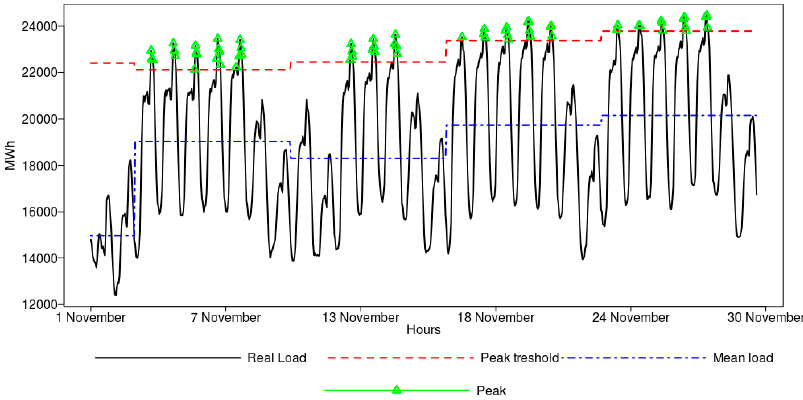
Figure 4. Peak identification in the load data based on the 90th quantile of the weekly load distribution (November 2015 data).